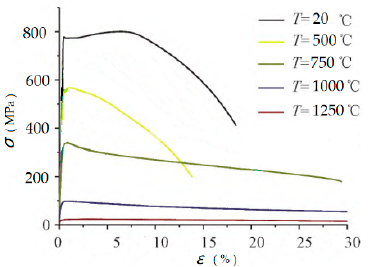
Figure 1. Thermo-mechanical properties of the Q690D steel.